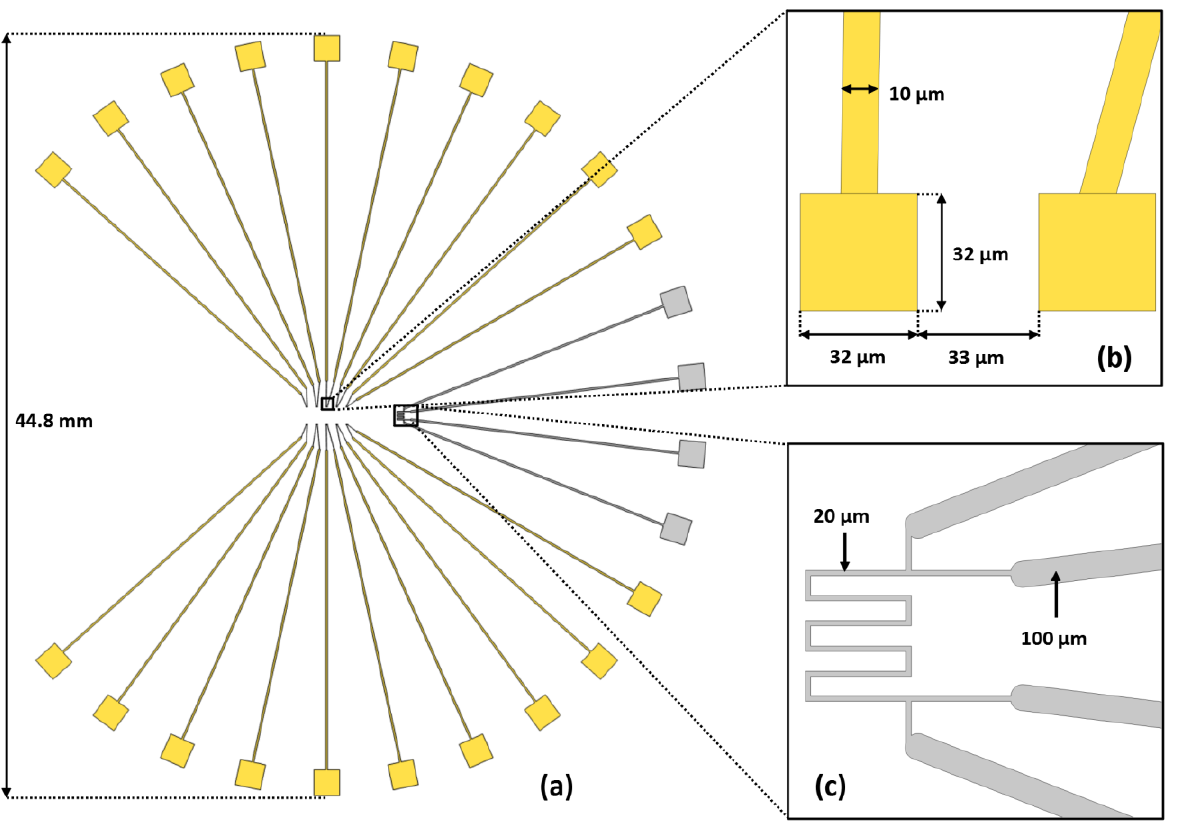
Figure 2. Schematic of the microelectrodes for BIS. ( a ) A global schematic: microelectrodes and their tracks are in yellow; the thermal sensor and its tracks are in gray. ( b ) A sensitive extremity of a microelectrode pair. The square extremity is 32 µm per side, and the SiO 2 isolation layer covers a 1 µm perimeter of the Pt, making the final contact area with the biological medium 30 µm per side. ( c ) The temperature sensor makes in a Pt track.